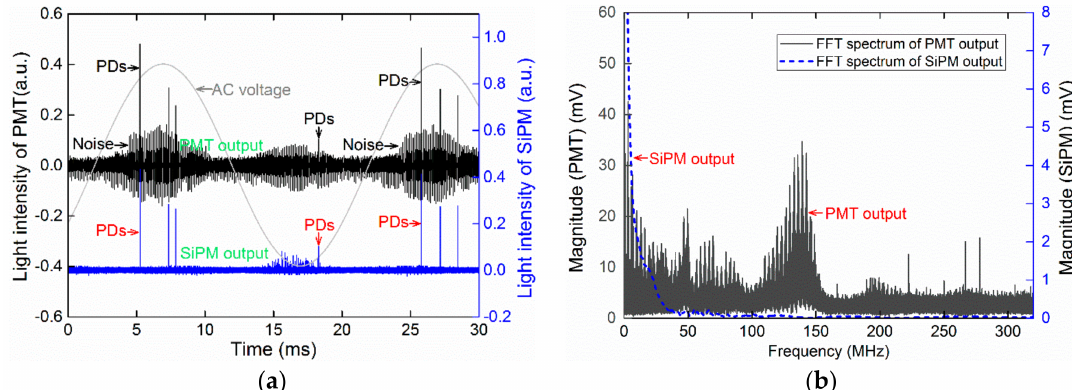
Figure 9. PD outputs of PMT and SiPM sensors in identical electromagnetic (EM) noise conditions. ( a ) Signals of SiPM and PMT in time domain; ( b ) FFT spectra of SiPM and PMT outputs. A high-frequency electromagnetic switch in operation is used as the actual noise source and